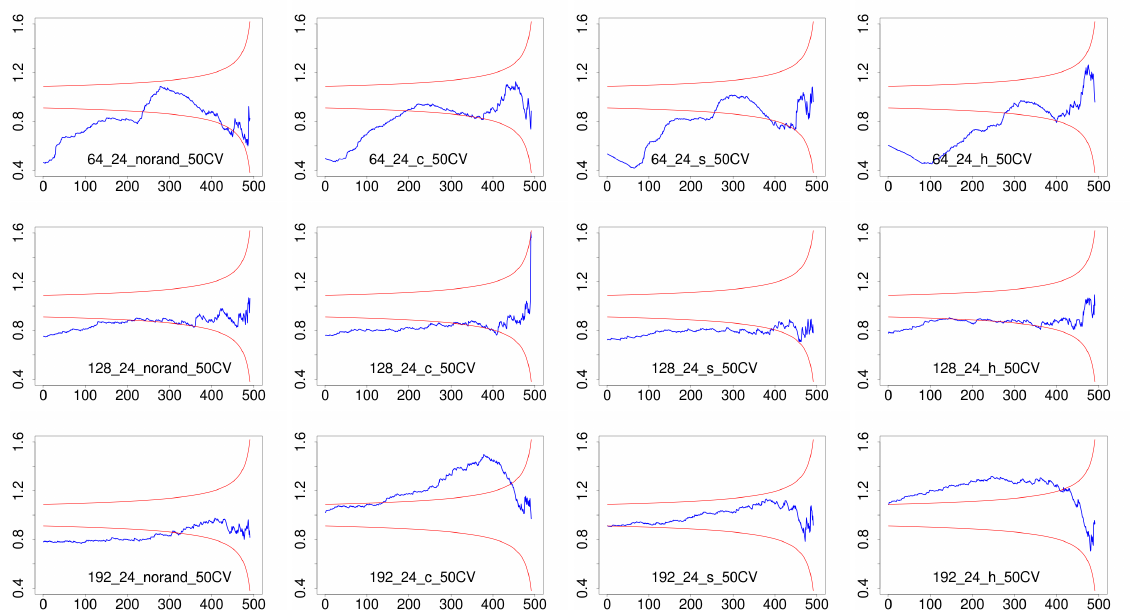
Figure 9. CV-plot for the FWI application with 24 threads. Plots correspond from top to bottom to 64 × 64 × 64 problem size, 128 × 128 × 128, and 192 × 192 × 192; and from left to right to no randomization, code randomization, stack randomization, and heap randomization respectively.